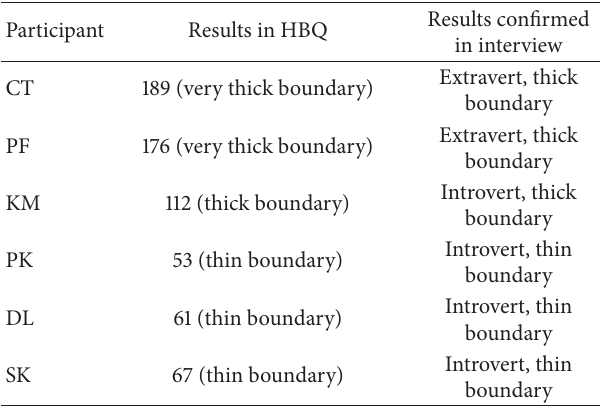
Table 1: Chosen questions in the HBQ questionnaire. Category 3 (16 items, score range 0–64): boundaries related to thoughts, feelings, and moods, for example, merging of thinking